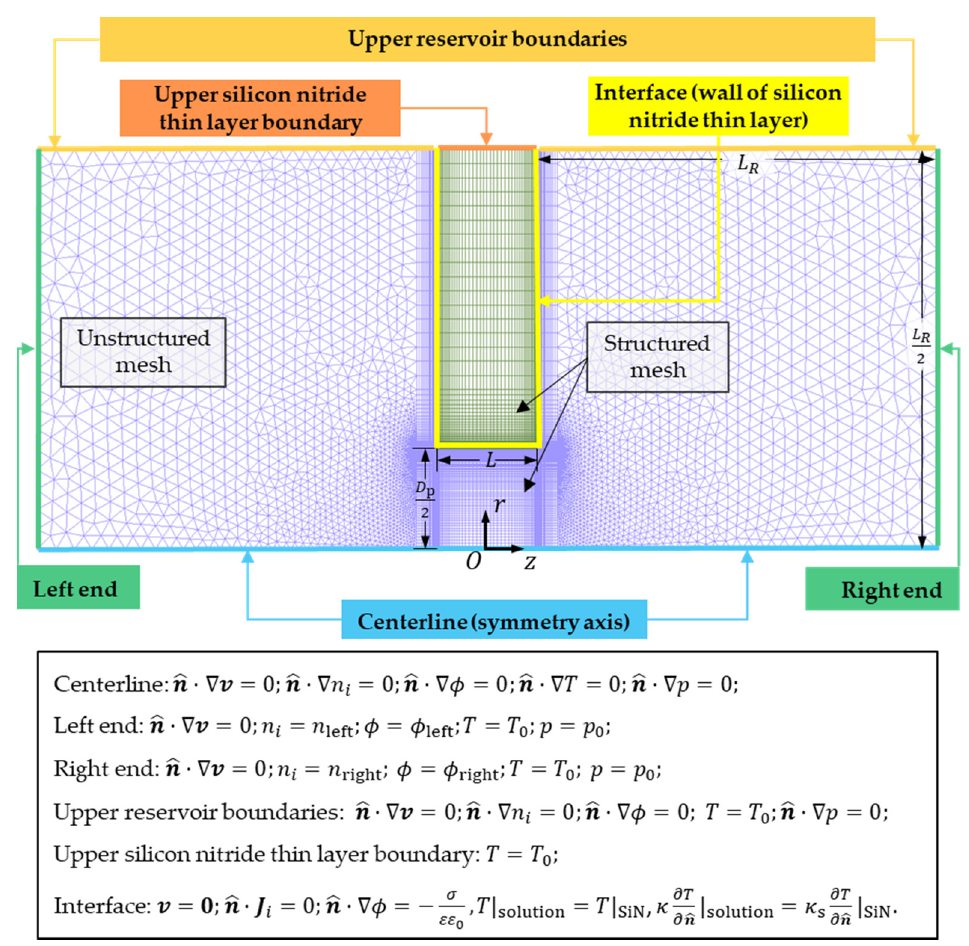
Figure 2. A hybrid computational mesh consists of unstructured and structured grids. Boundary conditions are listed in the underneath table. Note that the actual computational domain used is much larger to achieve mesh independence (see the Supplementary Materials Section S1).